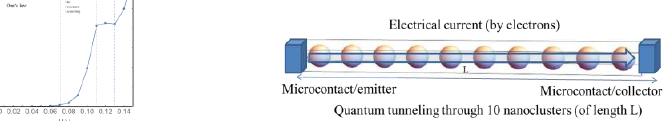
Fig. 3. Different regimes of electroconductivity in cluster systems (for Kronig-Penney model of superlattice – see 6on the right) due to relationship between electron energy and Fermi level. Vertical axis – current I, horizontal axis – voltage U (in arbitrary